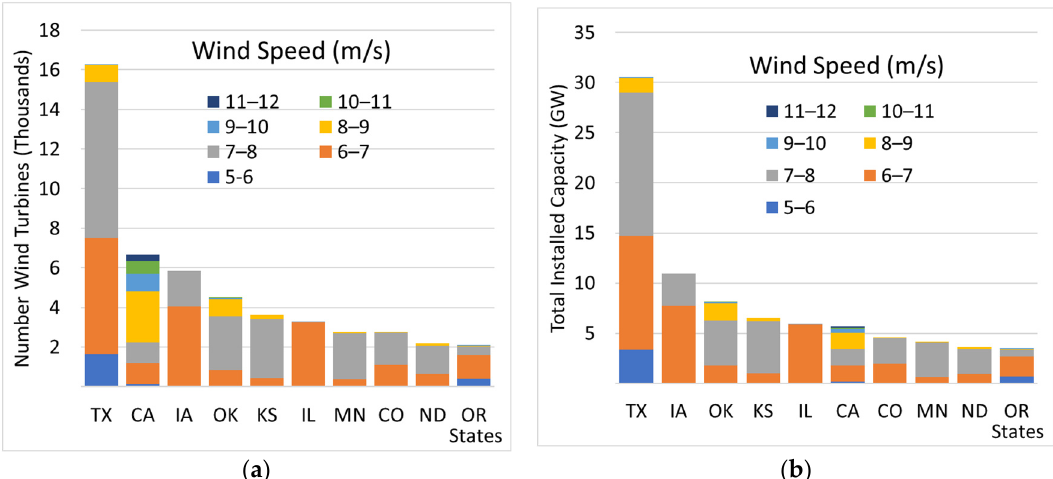
Figure 4. Wind turbines in 12 states that contain more than 80% of installed wind capacity in the U.S. ( a ) Number of wind turbines, including 2058 wind turbines with no NPC data in California. ( b ) Total installed capacity (GW).